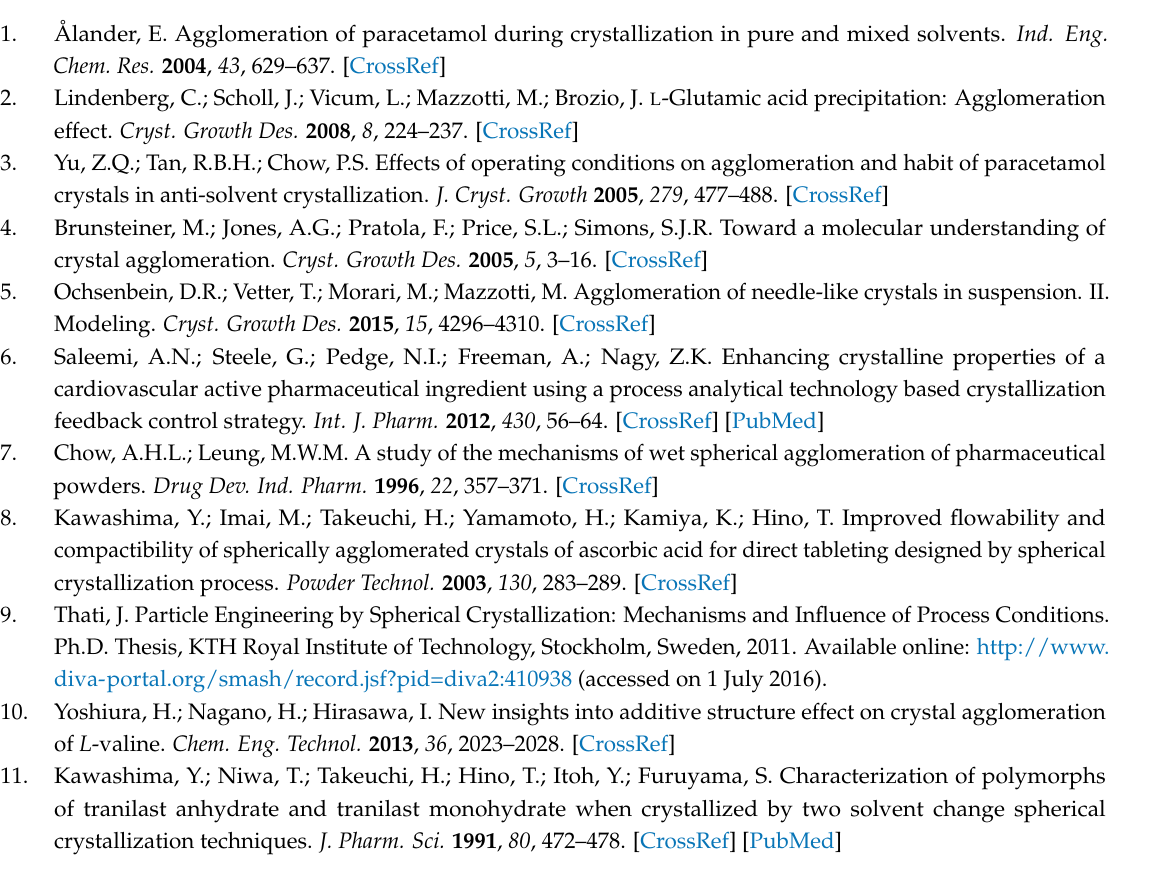
Figure S1: Temperature profile and total counts evolution during a preliminary cycling experiments performed in order to establish the best cycles’ amplitude and rate, Figure S2: Microscopic images of crystals during the cycling experiment of Figure S1, Figure S3: Microscopic images of crystals during the cycling experiment 1 (2% membrane seeds), Figure S4: Microscopic images of crystals during the cycling experiment 2 (6% membrane seeds), Figure S5: Microscopic images of crystals during the cycling experiment 3 (antisolvent seeds), Figure S6: Microscopic images of crystals during the cycling experiment 4 (polymorphic transformation seeds), Figure S7: FBRM statistics during cycling experiments 1, 3 and 4, Figure S8: Temperature, total counts, Raman intensity and microscopic images of crystals for the DNC experiment 1, Figure S9: Temperature, total counts, Raman intensity and microscopic images of crystals for the DNC experiment 2, Figure S10: Microscopic images of crystals during the DNC experiment 1, Figure S11: Microscopic images of crystals during the DNC experiment 2, Table S1: Malvern Mastersizer data for the seeds and the crystals at the end of the DNC experiment